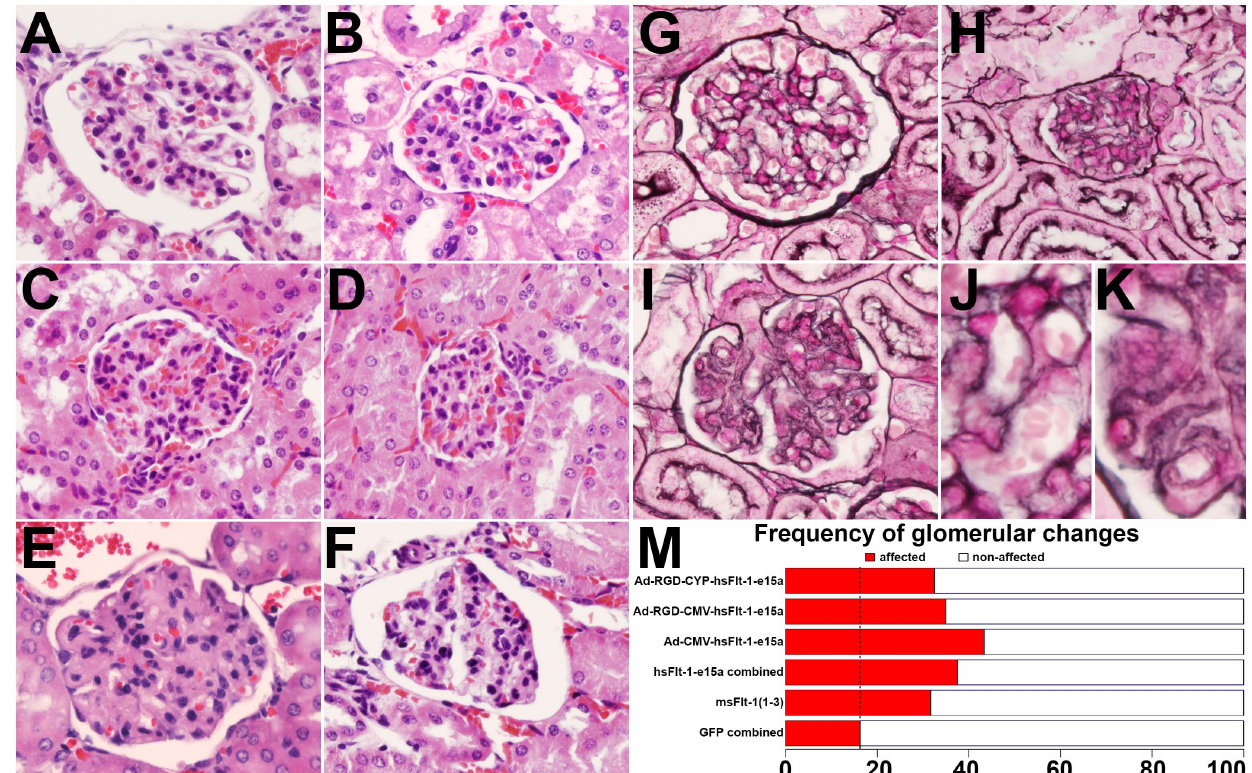
Figure 6. Histopathological evaluation of the kidneys. ( A,B,G ) Representative H&E (A: Ad-RGD-CMV-GFP, B: Ad-RGD-CYP-GFP) and Jones (G: Ad-RGD-CMV-GFP) stained sections show morphologically normal glomeruli in control animals. ( C,D,F,H ) Representative H&E (C: Ad-RGD-CMV-sFlt-1- e15a, D: Ad-RGD-CYP-sFlt-1-e15a, F: Ad-CMV-sFlt-1-e15a) and Jones (H: Ad-RGD-CMV-sFlt-1-e15a) stained sections show glomeruli with signs of swollen capillary endothelial cells and occlusion of glomerular capillaries in mice overexpressing sFlt-1-e15a. ( E,I ) Representative H&E (E) and Jones (I) stained sections show glomeruli with signs of swollen capillary endothelial cells and occlusion of glomerular capillaries in the dam overexpressing msFlt-1(1-3) with chronic hypertension. 400x magnifications. ( J ) High magnification image (1200x) from sub-image G shows a normal capillary structure. ( K ) High magnification image (1200x) from sub-image I shows thickened capillary loops. ( M ) The glomerular damage score was significantly higher in all treatment groups compared to the combined control group. Mice treated with msFlt-1(1-3) had an odds ratio (OR) of 2.4 for